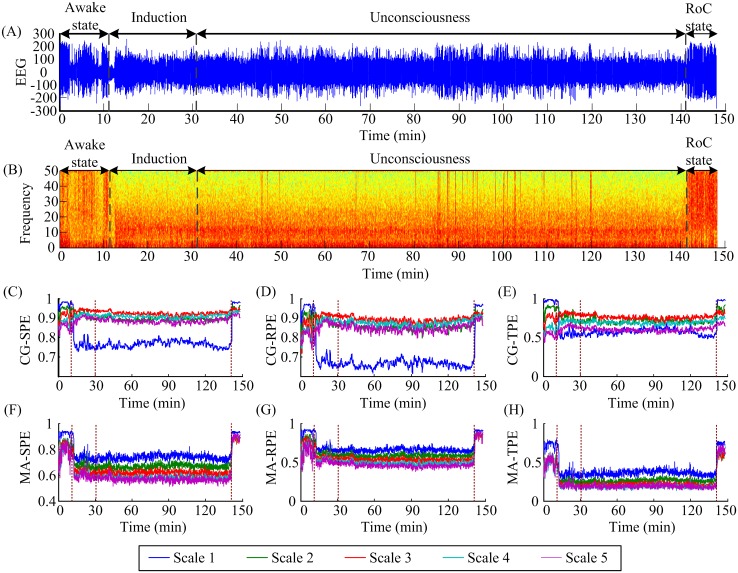
An EEG recording from one patient, its spectrogram and corresponding MSPE indexes.(A) The EEG recording. The EEG recordings are divided into four states: awake state, induction, unconsciousness and RoC states. (B) The spectrogram of the EEG signal. (C-H) The corresponding CG-SPE, CG-RPE, CG-TPE, MA-SPE, MA-RPE and MA-TPE indexes of the signal at five decomposition scales. Different colors represent different decomposition scales.